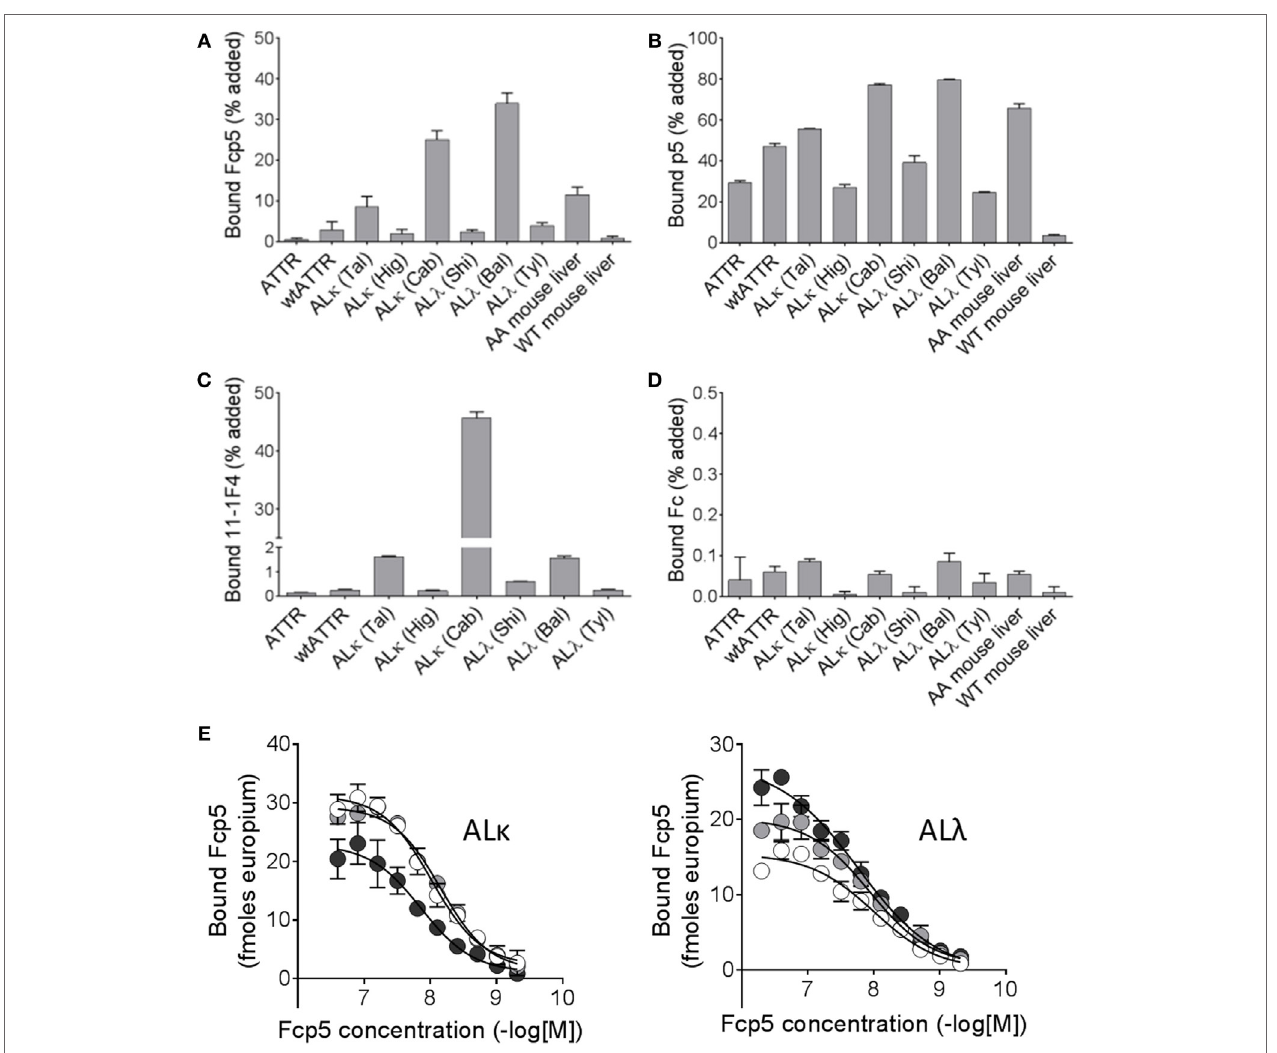
FigUre 4 | Radioiodinated Fcp5 binds human and murine amyloid extracts. Proteins Fcp5 (a) , p5 (B) , 11-1F4 (c) , and Fc2a (D) were radiolabeled and used in a pulldown assay to assess binding to human ATTR extracts, AL extracts, and mouse AA homogenates. (e) Binding of Fcp5 to surface-adsorbed human AL κ and AL λ amyloid extracts (three different patients per isotype) was assessed by europium-linked immunosorbent